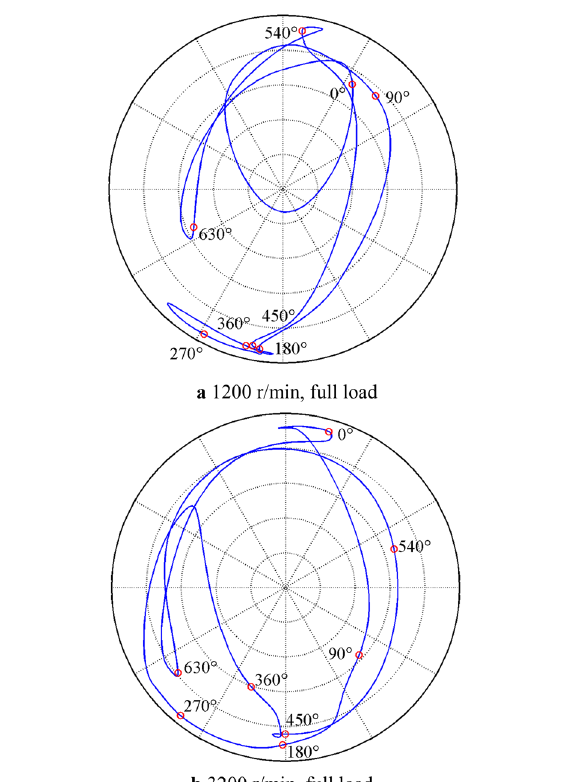
Figure 6 Journal axis orbit of No. 2 main bearing